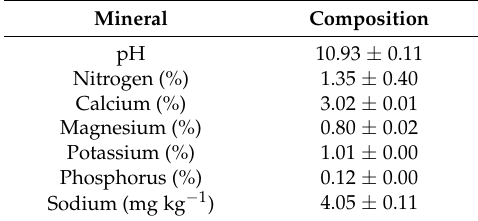
Table 1. Chemical composition of palm bunch biochar.